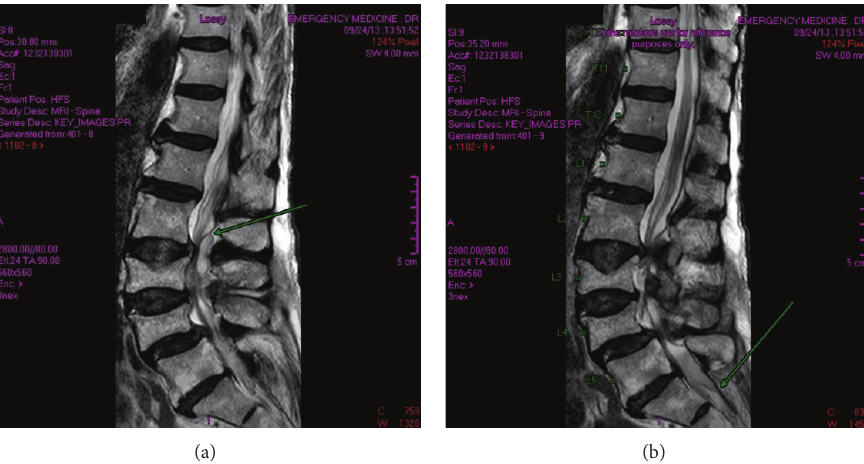
Figure 1: (a) T2 weighted image. A 2-3 mm anterolisthesis of L4 with respect to L5 is demonstrated; vertebral bodies are otherwise normally aligned. Increased signal intensity and a wall enhancing fluid collection are seen in the posterior epidural space. This extends from L2 to S1; the arrow depicts the upper extent. (b) T2 weighted image. Loss of vertebral body height and increased endplate concavity at T9, L3, and L4. Accompanying linear areas of signal loss are characteristic of fractures parallel to the superior end plates of T9 and L4. An anterior epidural abscess component is shown from L3 to L4. Posterior extension of the abscess is shown to S1 level as indicated by the arrow.